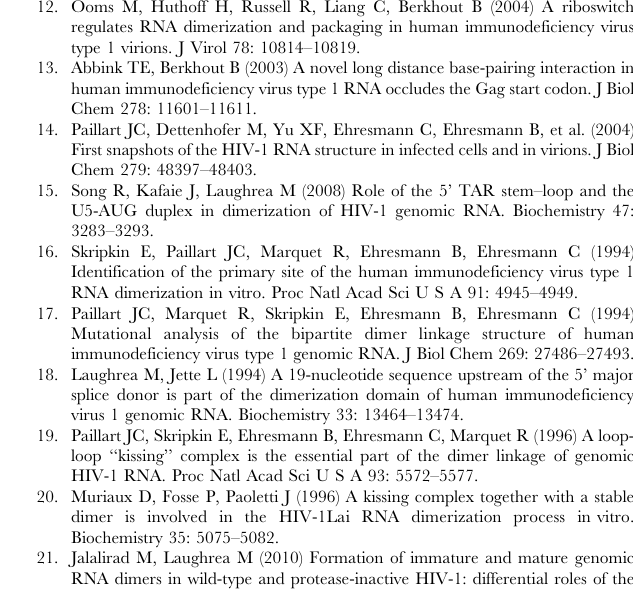
Figure S3 Gel electrophoresis to evaluate the effect of PNA oligomers on the template-switching efficiency between the acceptor and donor HIV-1 transcripts: Acceptor, donor transcripts and radiolabeled GR primer (anneals to the donor transcript) were incubated in the dimerization buffer with increasing molar excess of respective PNA oligomer, as indicated at the top of each gel. This reaction mixture was used for the next template-switching efficiency assay, for details see Materials and Methods. Samples were analyzed on the 6% denaturing TBE gel. Each gel picture having the following loading pattern. Lane1: HIV-1 leader transcripts including the AUG codon of gag gene, Lane2- Donor transcript, Lane3-7- Donor and acceptor transcripts with increas- ing concentration of anti-sense PNA in molar ratio (with respect to the concentration of donor transcript) as indicated on top of gel, Lane8- Donor and acceptor transcripts without PNA oligo. FT- switched product, F- Full-length donor